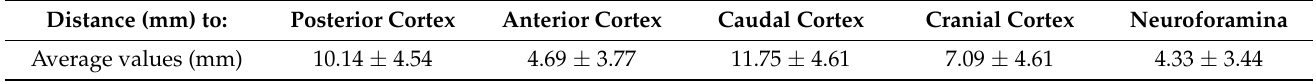
Table 3. Data gained from the postoperative CT-images. Measurement of distance from the cortex.